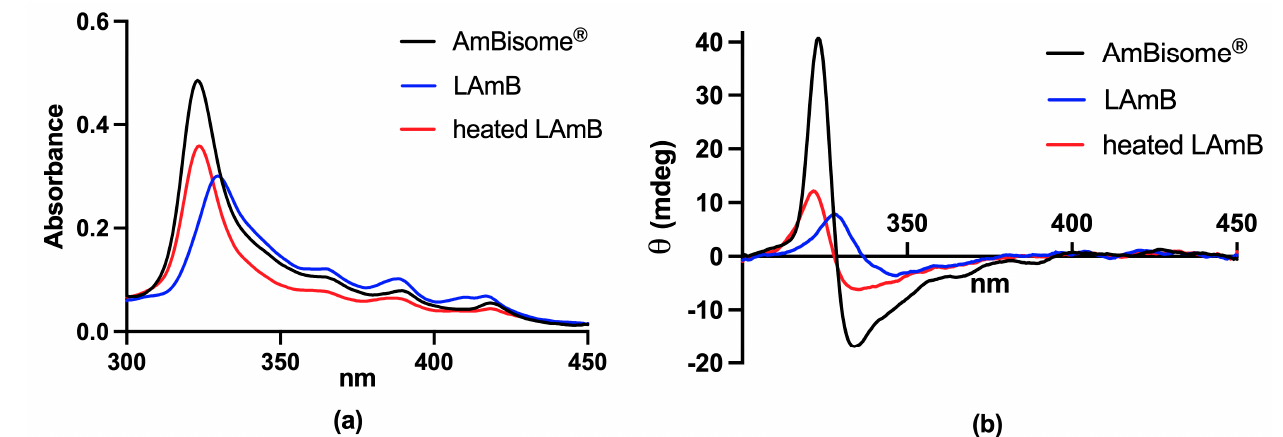
Figure 7. Absorption ( a ) and circular dichroism ( b ) spectra of conventional liposomal AmB (LAmB) prepared according to [77], before and after 4 h heating at 60 ◦ C, in comparison to AmBisome ® . Lyophilized LAmB was reconstituted with water at 4 mg/mL AmB and submitted or not to heat curing. Spectra were registered at 25 ◦ C after reconstitution of the nanoformulations in water and